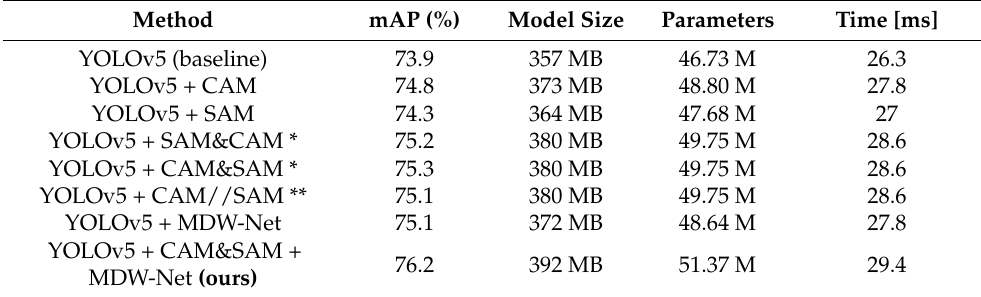
Table 2. Ablation studies on